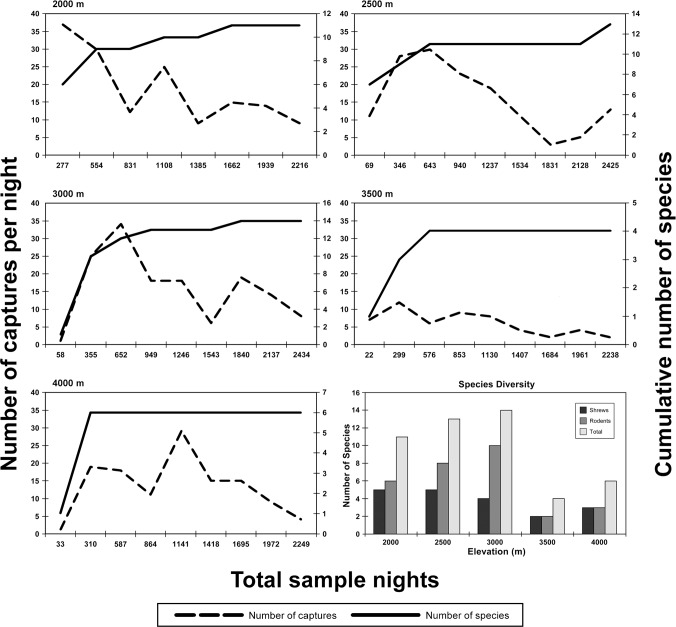
Species accumulation curves (for both pitfall and trap lines combined) for each site surveyed for small mammals on Mt. Meru.The dashed lines represent the number of captures each day; the solid lines represent the cumulative number of new species for the site observed each day. The graph at the lower right shows the number of specimens of shrew, rodent, and combined small mammals captured at each site.